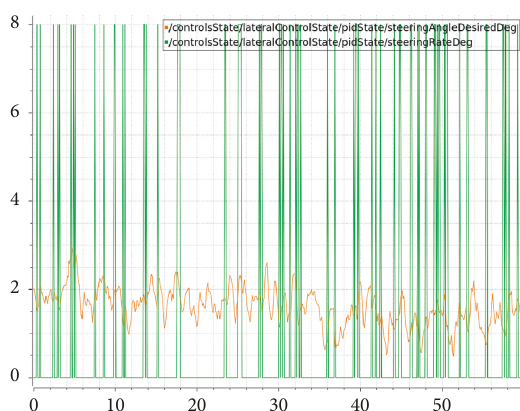
Figure 51: T2D3 steering degrees.